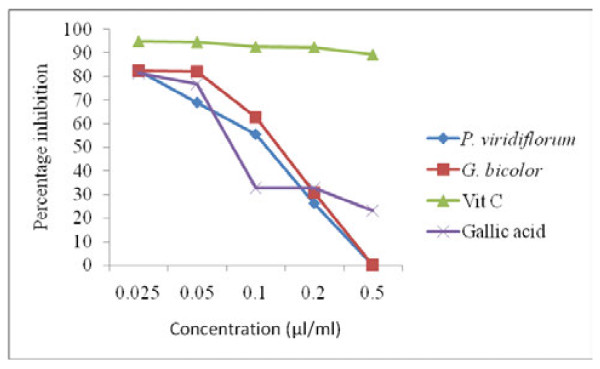
H2O2 scavenging activity f G. bicolor (leaf) and P. viridiflorum (bark) extracts. Results are means of 3 replicates.